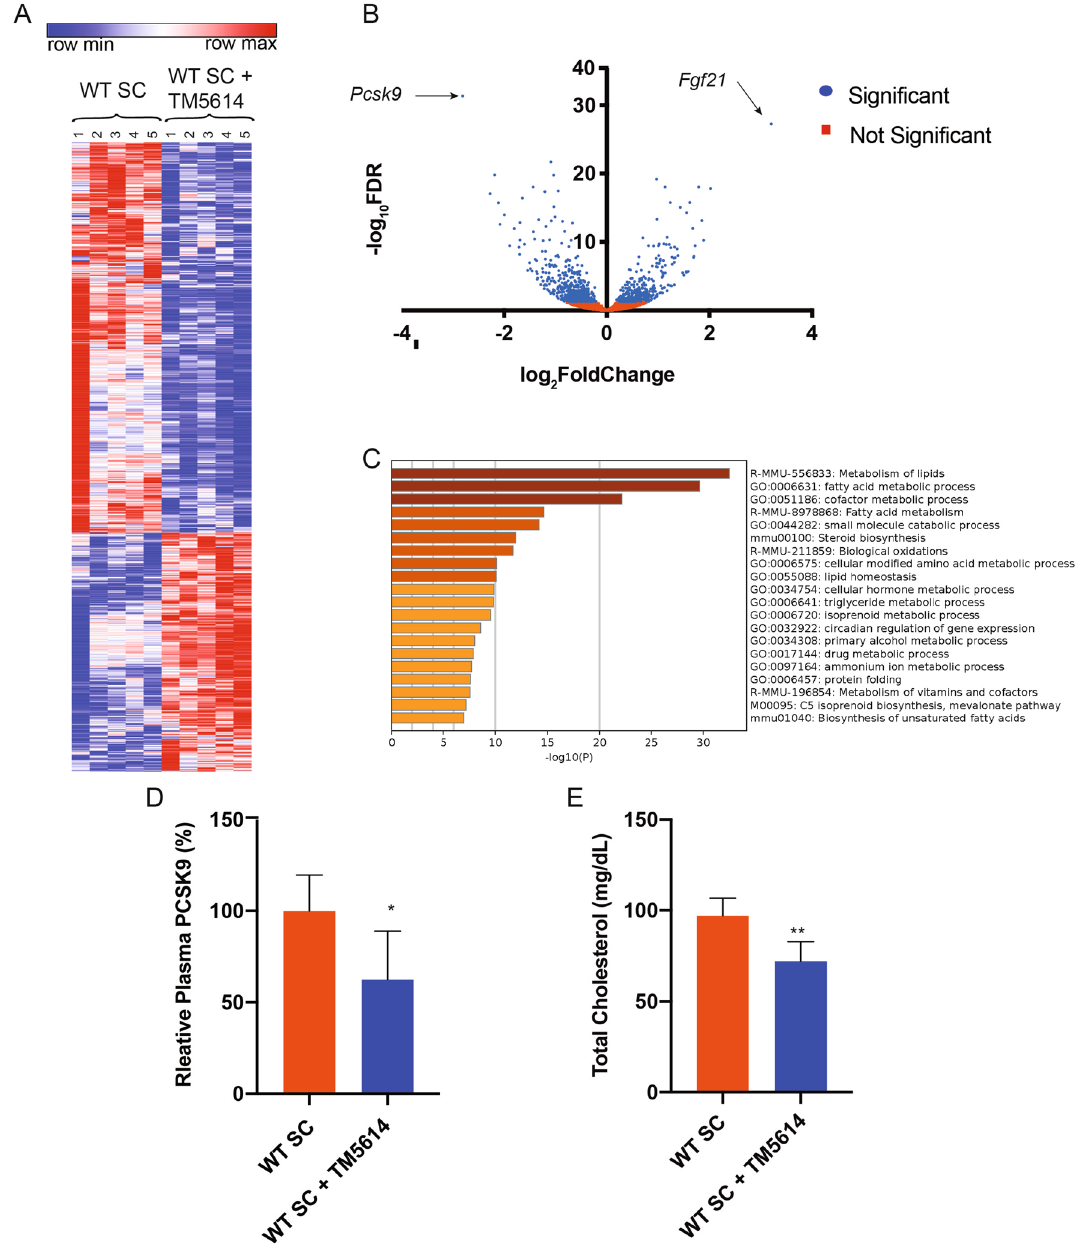
Figure 1. Pharmacological inhibition of PAI-1 with TM5614 regulates Pcsk9 . 20 week-old wild-type C57BL/6 J male mice fed SC were administered a PAI-1 inhibitor, TM5614, given orally (20 mg/kg/day) for 10 days. At the endpoint hepatic mRNA and murine plasma were analyzed. ( A ) Hierarchical clustering of expression changes seen by RNA-seq. Heat map created using Morpheus (https ://softw are.broad insti tute.org/morph eus/). ( B ) Volcano plot representation of all gene expression changes. Blue points represent statistically significant changes and red points represent non-significant changes. ( C ) Gene ontology analysis of statistical differentially expressed genes. Data generated using Metascape (https ://metas cape.org/gp/index .html#/main/step1 ). ( D ) Murine plasma PCSK9 levels. ( E ) Total Cholesterol levels in mouse plasma. Values are expressed as mean ± SEM (n = 5), * p < 0.05, ** p <